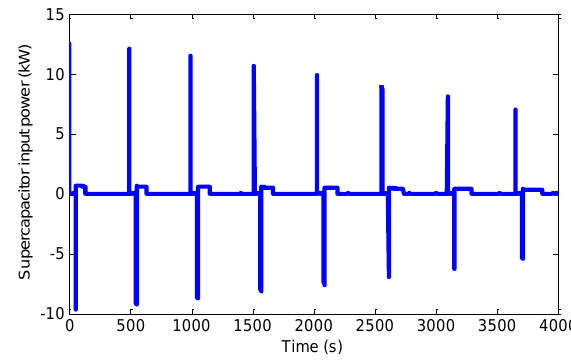
Figure 6. Supercapacitor input charging/discharging power.